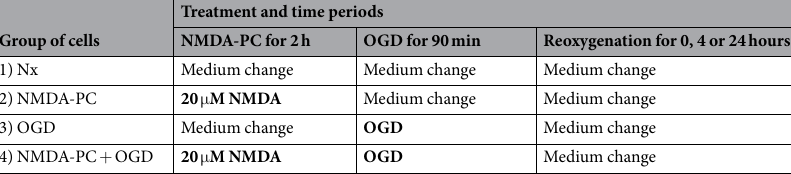
Table 1. Experimental NMDA-PC model of neurons in primary culture. Mouse cortical neurons at 9–10 DIV were exposed to four different conditions: I) a group of cells (Normoxia; Nx group) was incubated at 37 °C in a humidified atmosphere of 95% air/5% CO 2 in buffered Hanks’ solution. Under these condition, oxygen concentrations in the incubation medium were 190 ± 15 μ M as measured with a Clark-type oxygen electrode; II) a second group of cells was exposed to a moderated concentration 20 μ M NMDA for 2 hours NMDA-preconditioning; NMDA-PC); III) group of cells exposed to oxygen and glucose deprivation for 90 min (OGD) or IV) 20 μ M NMDA for 2 hours prior to a subsequent lethal oxygen glucose deprivation (OGD; 90 min) (NMDA-PC + OGD). Neurons were then incubated in cultured medium for further 0, 4 or 24 hours of